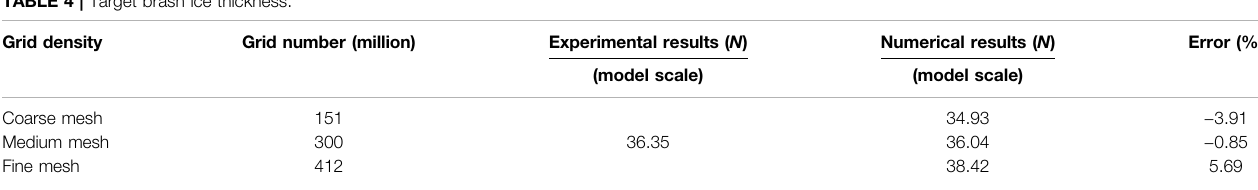
TABLE 4 | Target brash ice